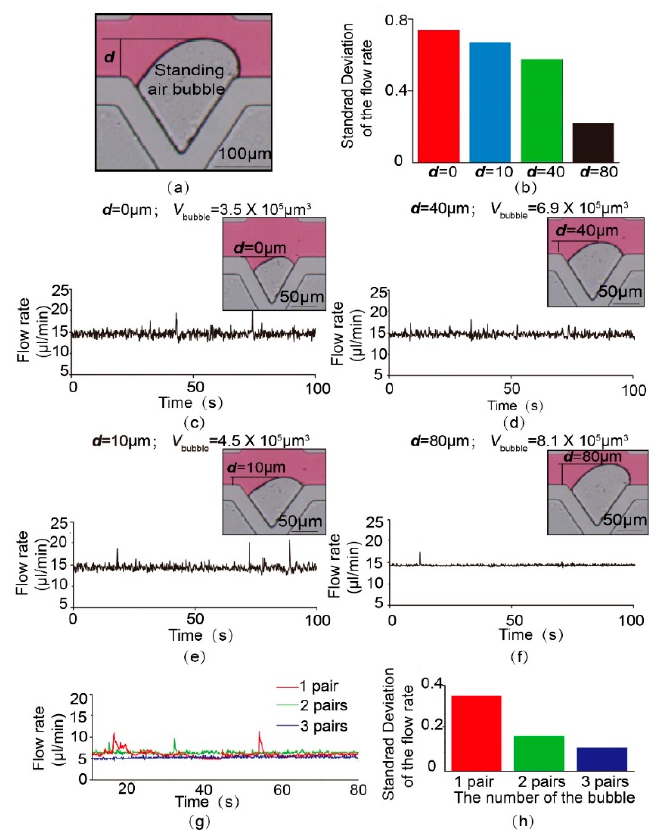
Figure 6. Output flowrates of bubble-based microfluidic stabilizer with different bubble sizes and numbers. ( a ) The illustration and experimental picture of the critical parameters affecting the flow stabilizing performance of this syringe stabilizer. ( b ) The standard deviation of the flowrate data with different sizes of the bubble. ( c – f ) Output flowrates of bubble-based microfluidic damper with different sizes of bubble (scale bar = 50 μ m). ( g ) Output flowrates of bubble-based microfluidic stabilizer with different numbers of bubbles. ( h ) The standard deviation of the flowrate data with different numbers of bubbles .